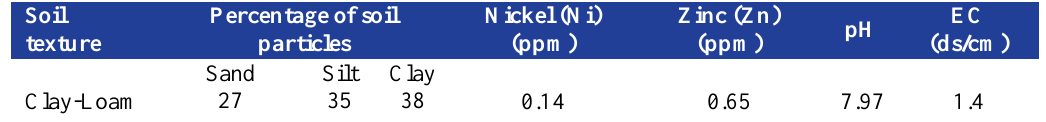
Table 1. Some physical and chemical properties of experimental soil.